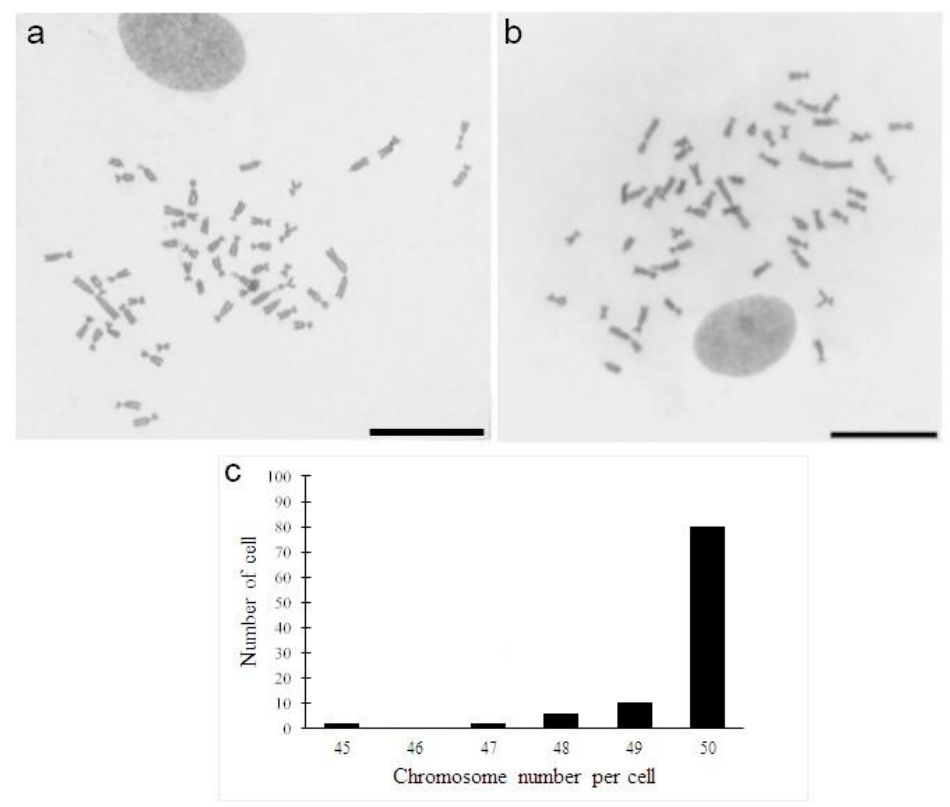
Figure 2. Chromosomes in metaphases obtained from fibroblastic cells of Astyanax altiparanae in the fourth passage before cryopreservation ( a ) and sixth passage after thawing ( b ). Scale bars 20 µ m. Frequency distribution of chromosomes of cells of Astyanax altiparanae in cells spreads ( c ).